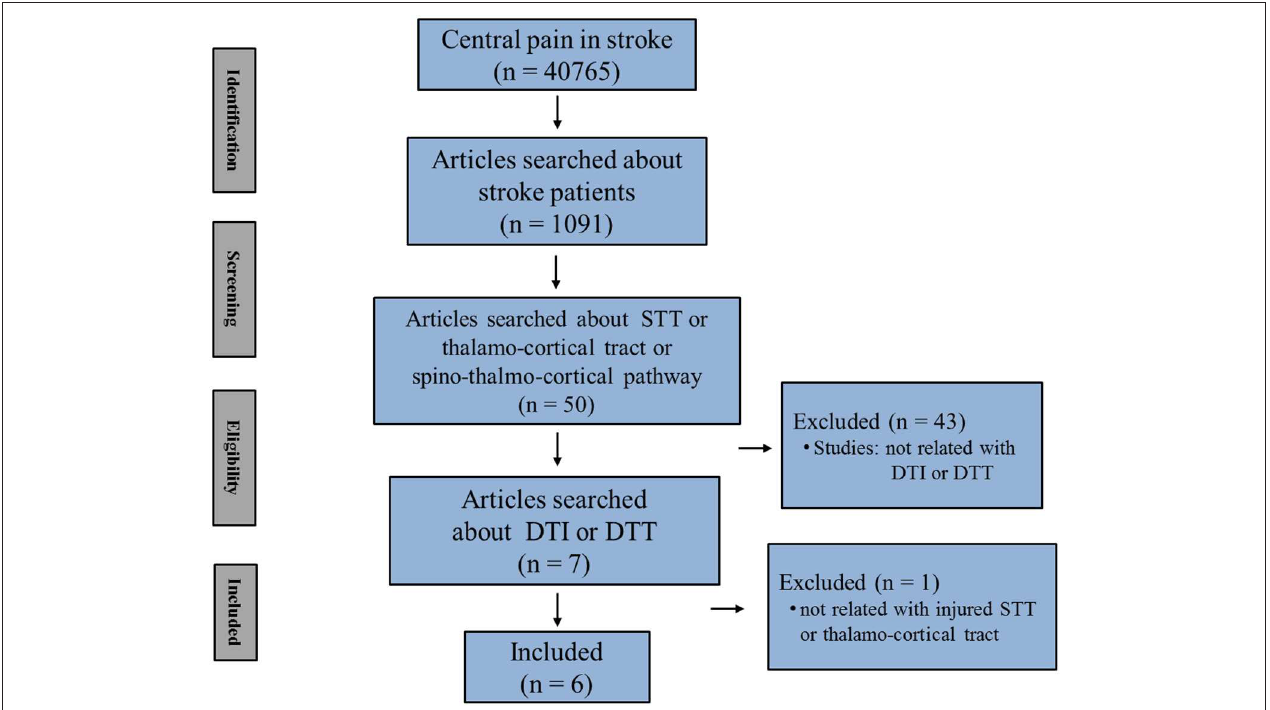
FIGURE 1 | Flow diagram of the study selection process (STT, spinothalamic tract; DTI, diffusion tensor imaging; DTT, diffusion tensor